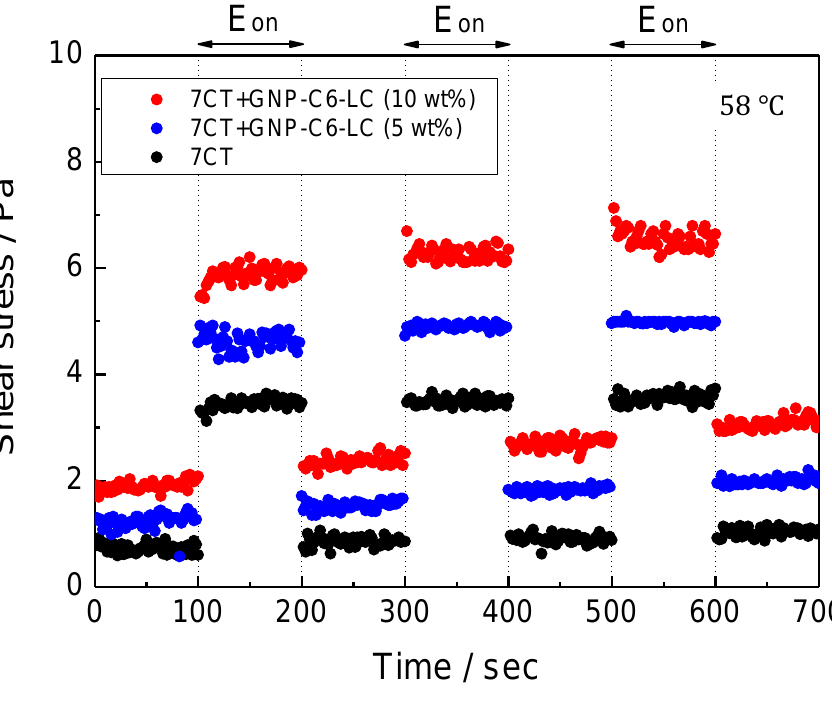
Figure 7. Electrorheological (ER) responses of 7CT and the composite (GNP-C6-LC (5, 10 wt%) in 7CT) under 3 kV mm − 1